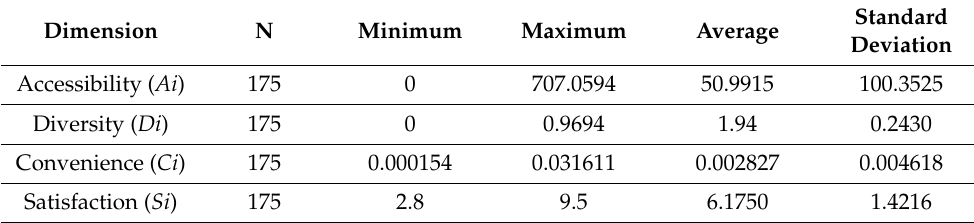
Figure 6. Measurement results for the four dimensions. Table 6. Descriptive statistics of the measurement results for the four